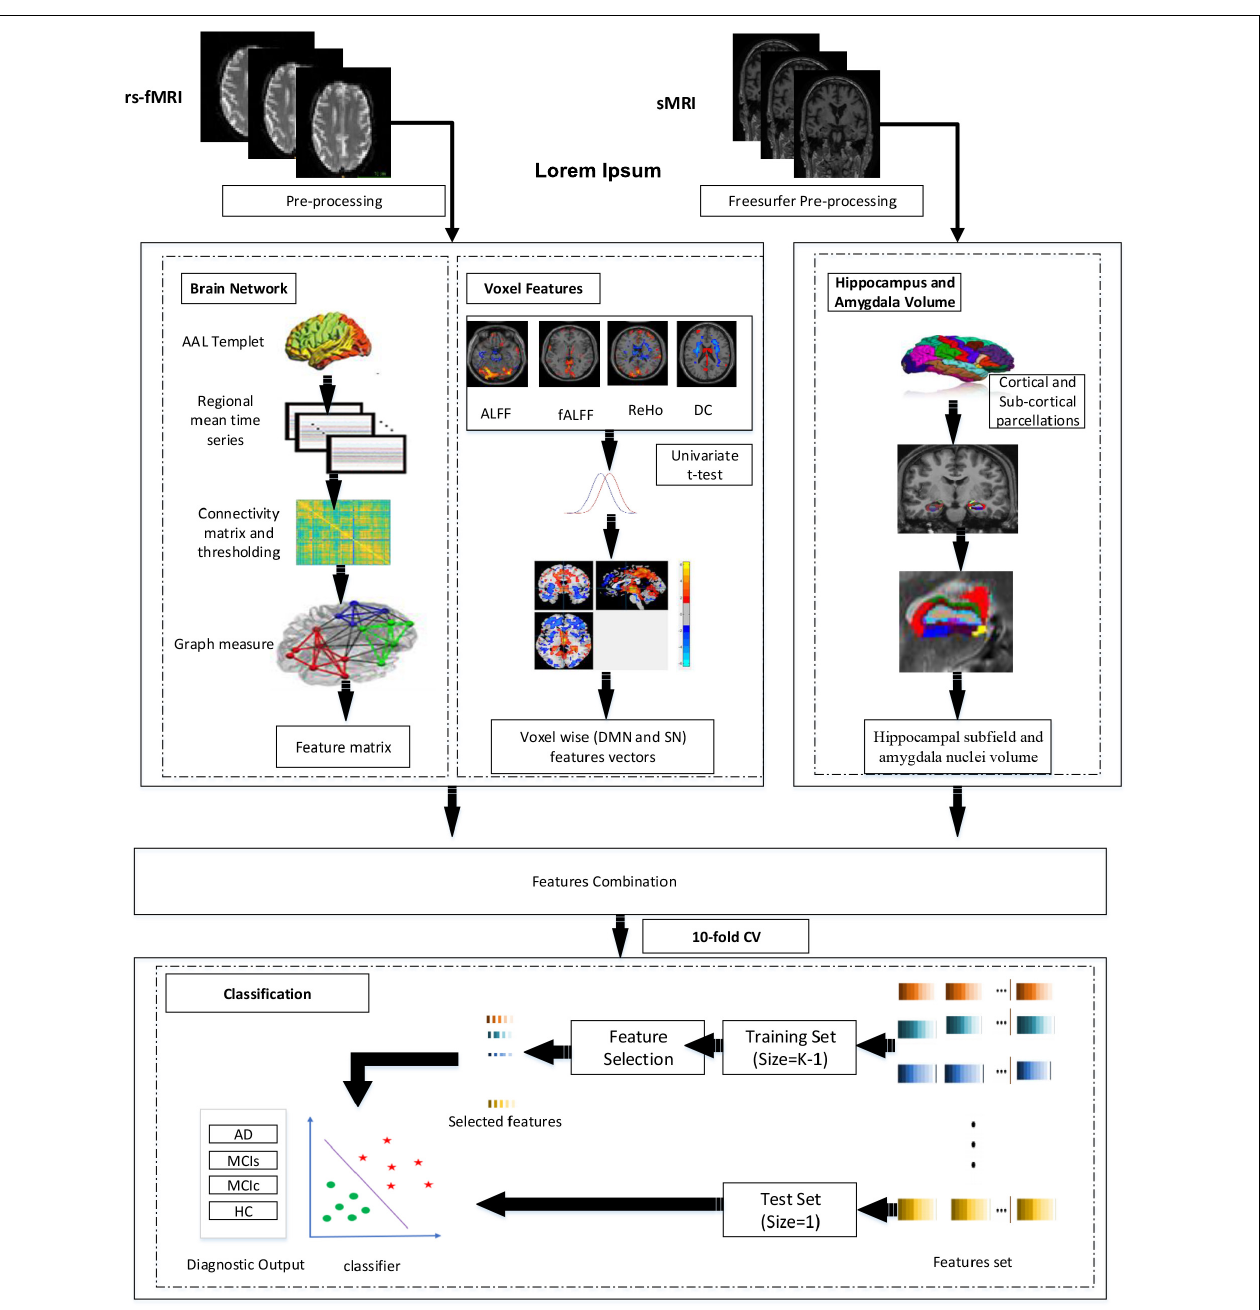
FIGURE 1 | Overview of the proposed